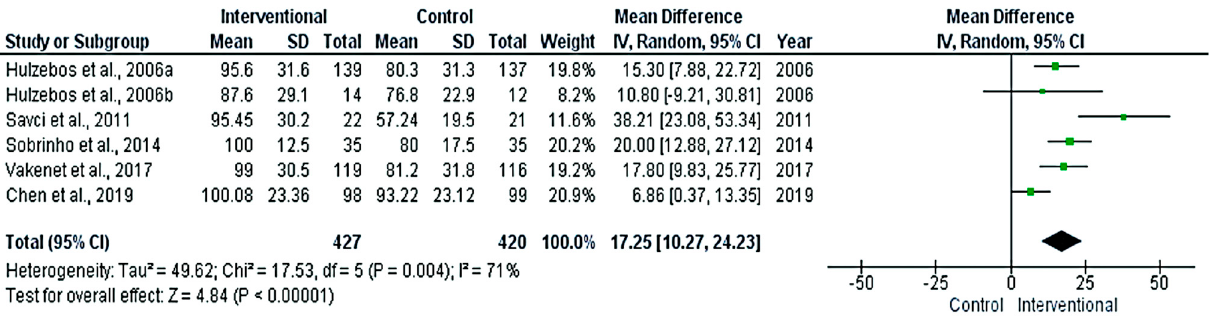
Figure 7. Forest plot evaluating FVC% predicted in the included studies.